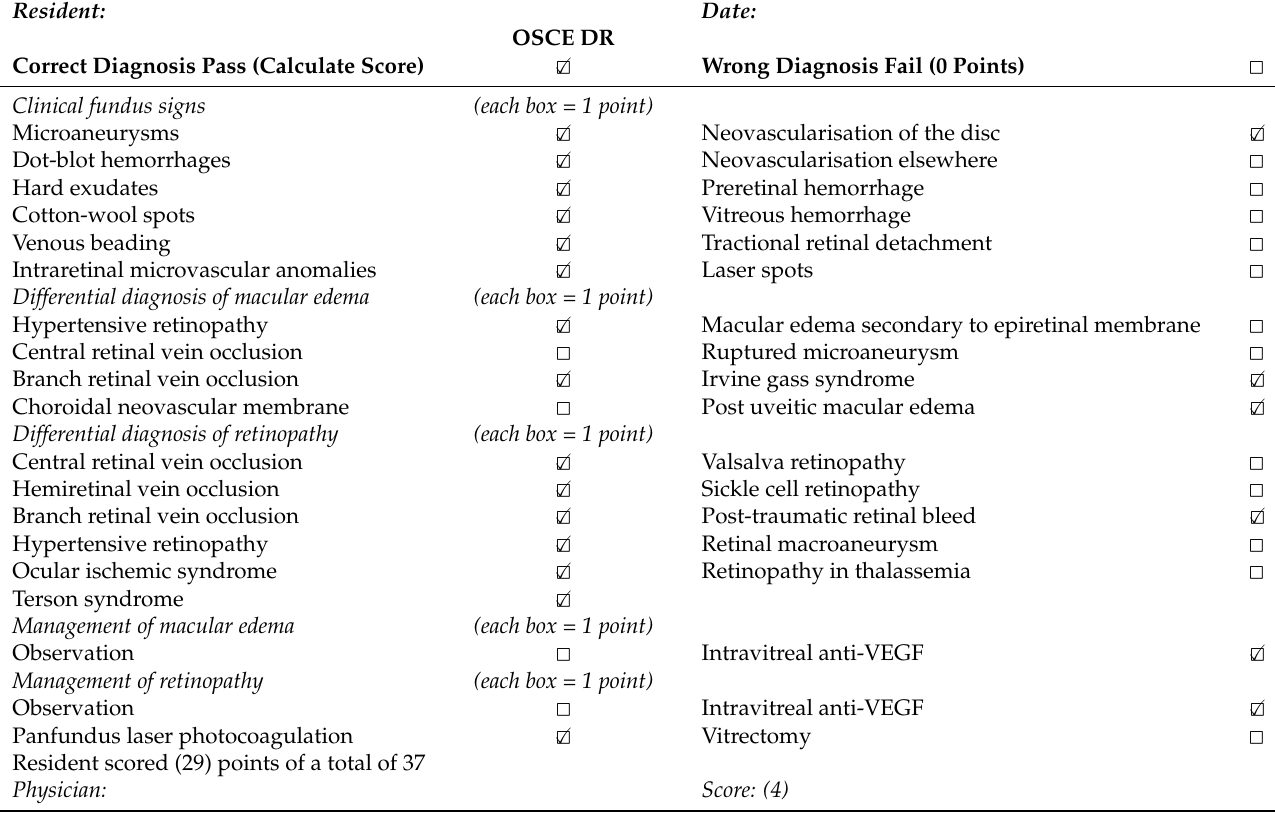
Table 6. Diabetic retinopathy OSCE evaluation file. The performance score corresponds to